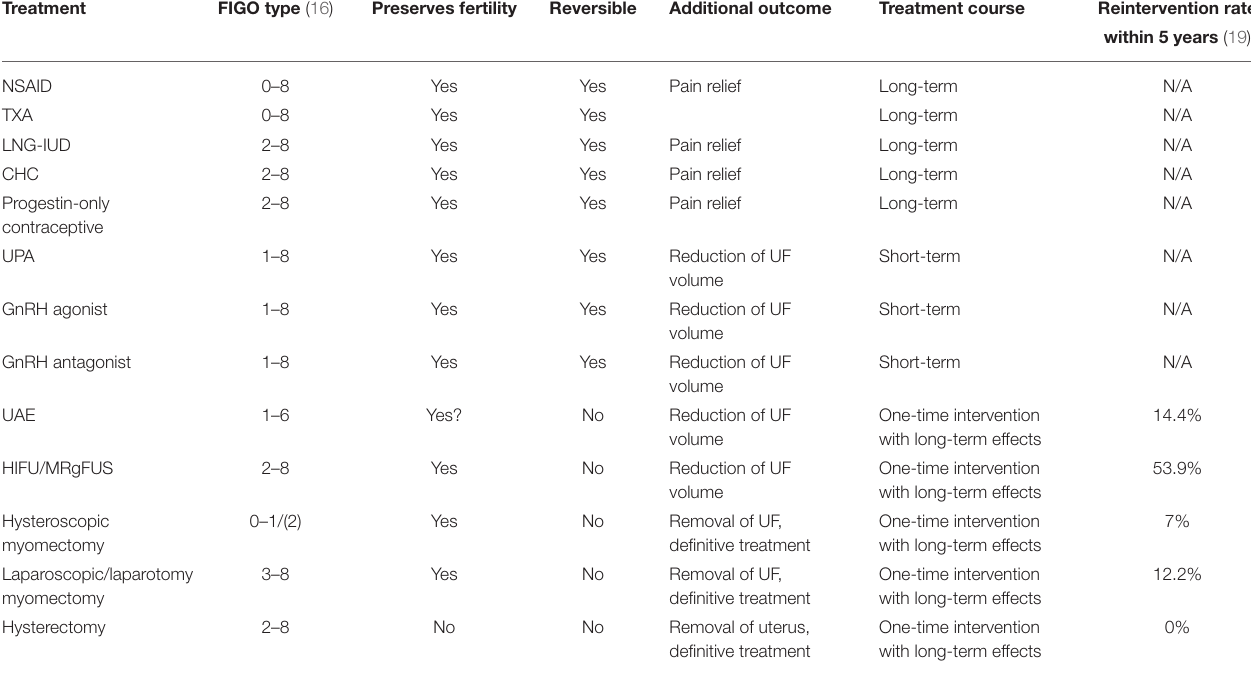
TABLE 1 | Comparison of treatment options for uterine fibroid-related heavy menstrual bleeding. Treatment FIGO type (16) Preserves fertility Reversible Additional outcome Treatment course Reintervention rate